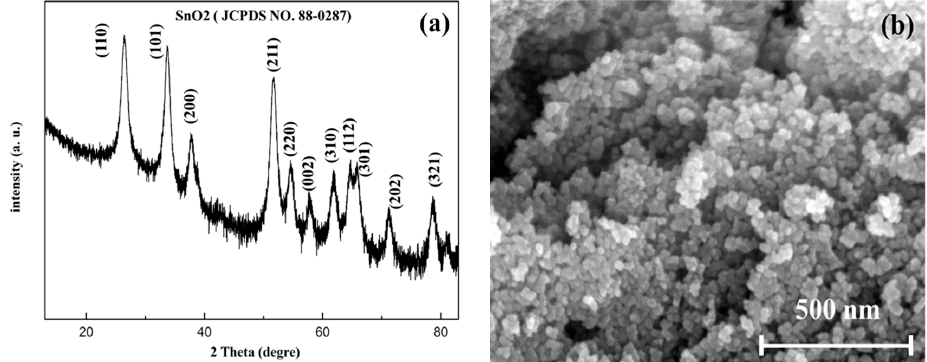
Figure 1. The parallel synthesis of gas sensing films. ( a ) The gas sensing film parallel synthesis platform. ( b ) The 8-matrices material substrate with sensing films. ( c – f ) Different magnifications of one gas sensing film.